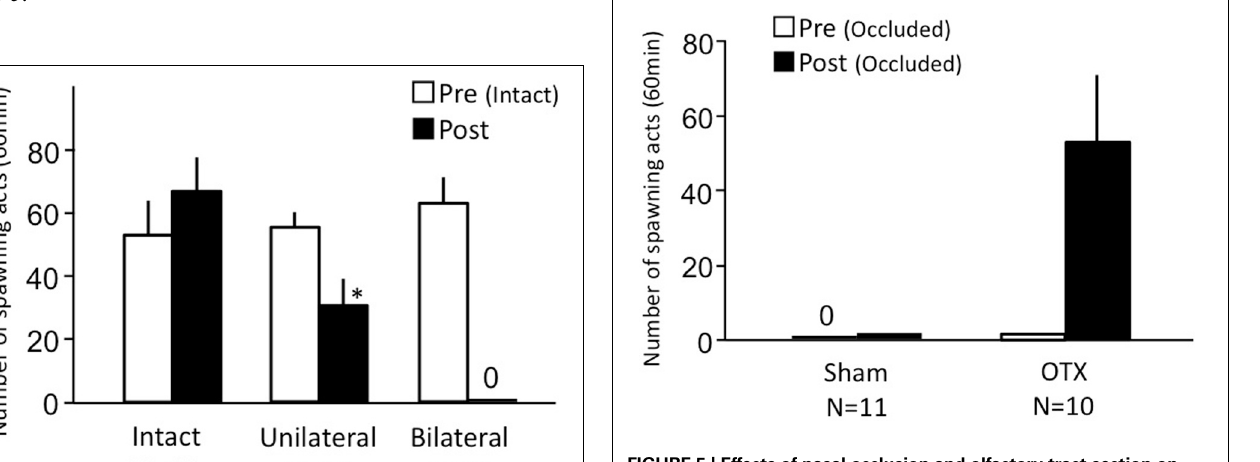
FIGURE 5 | Effects of nasal occlusion and olfactory tract section on female sexual behavior in female goldfish. Pre, Pre-treatment (bilaterally occluded). Post, post-treatment (bilaterally occluded and either sham-operated or olfactory-tract sectioned). Each column represents the mean and s.e.m.